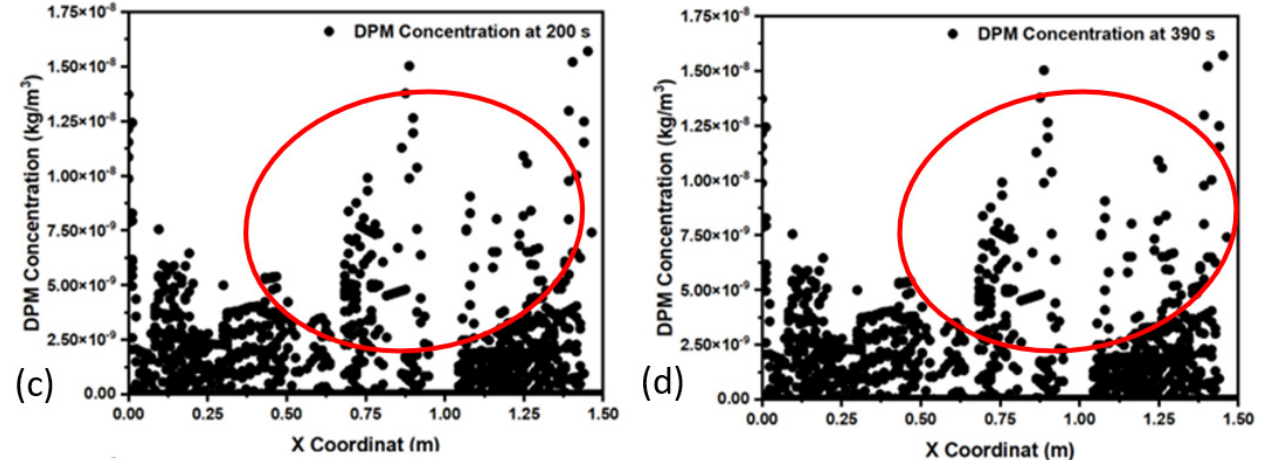
Figure 6. Inclusion (DPM) concentration with a 100-micron diameter in the mold at ( a , b ) 1853 K and ( c , d ) 1893 K.